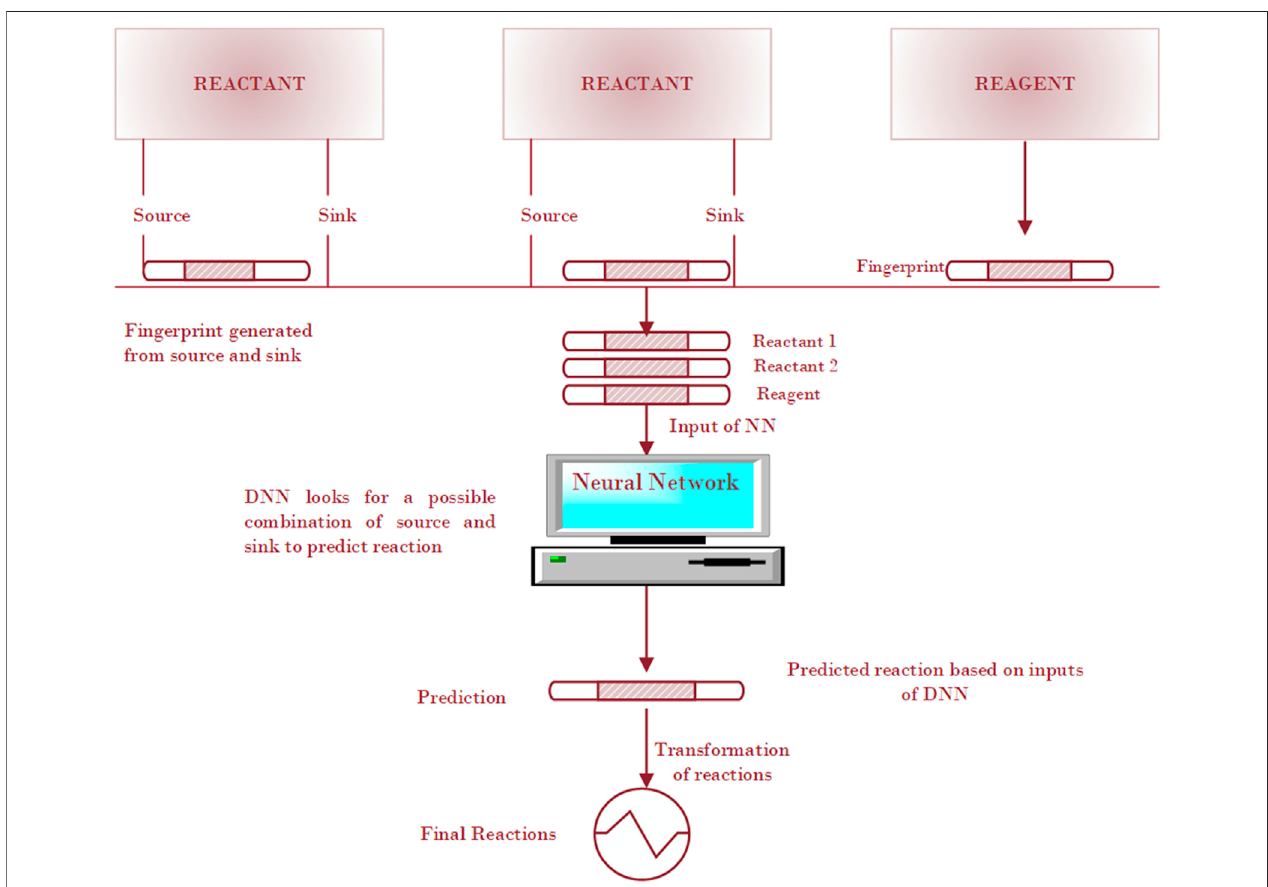
FIGURE 4 | Schematic illustration of a deep neural network method for the prediction of a